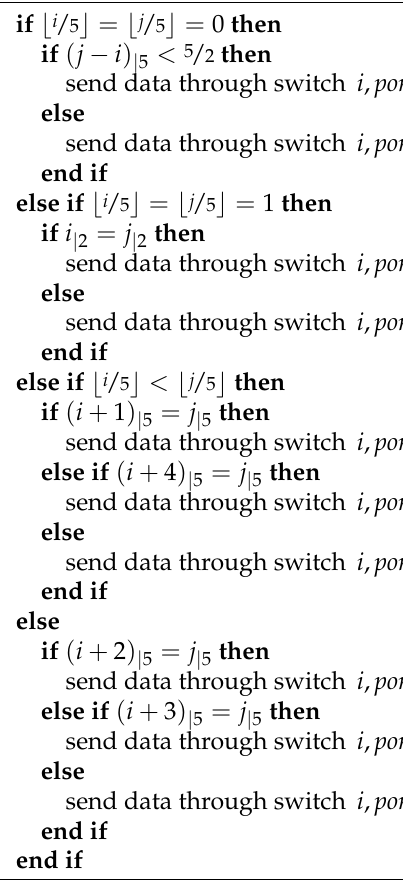
Algorithm 1: Moving from node i to node j in a Petersen